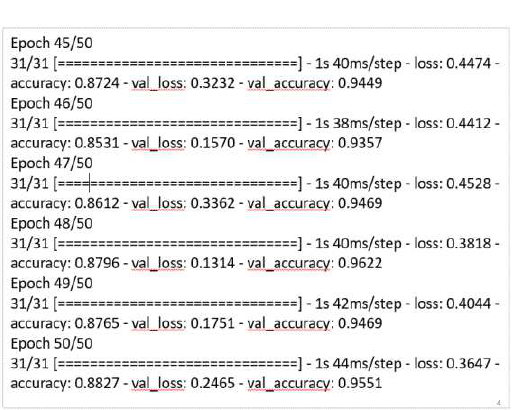
Fig. 9. Training the Model